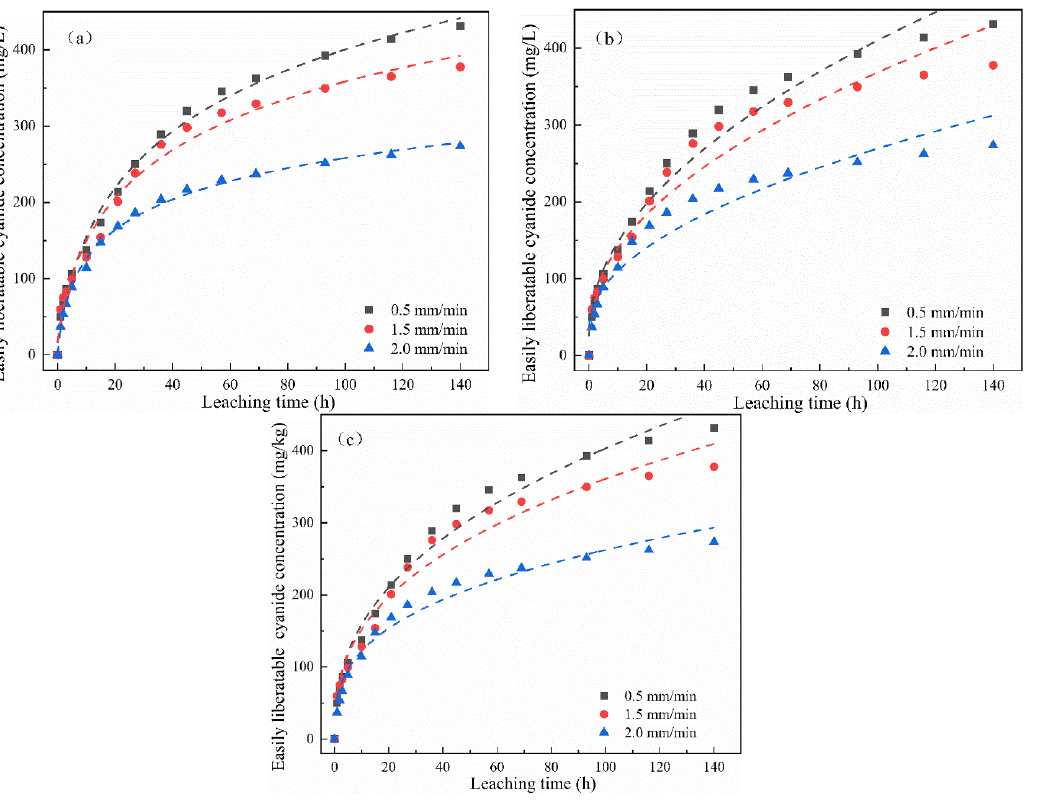
Figure 8. Nonlinear fitting using ( a ) Elovich, ( b ) parabolic diffusion, and ( c ) double constant equations of easily liberatable cyanide cumulative release over time under different leaching intensity.